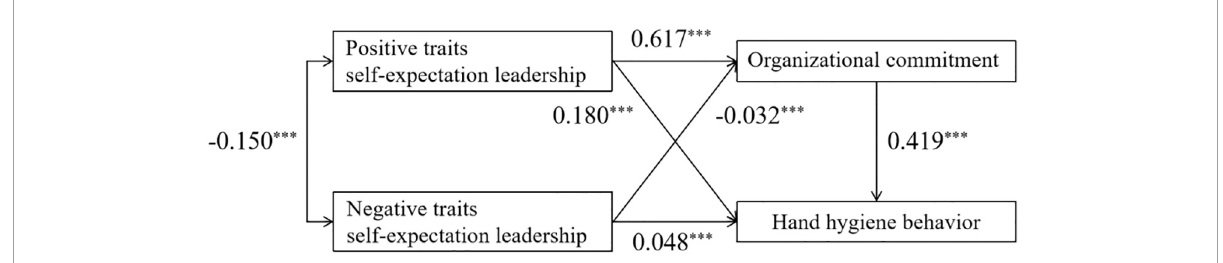
FIGURE1 The results of hand hygiene behavior (HHB) model based on the implicit leadership theory (ILT) theoretical framework. ∗∗∗ p < 0.001. Model fit indices: RMSEA = 0.076; NFI = 0.903; IFI = 0.903; CFI = 0.903; PGFI = 0.644.